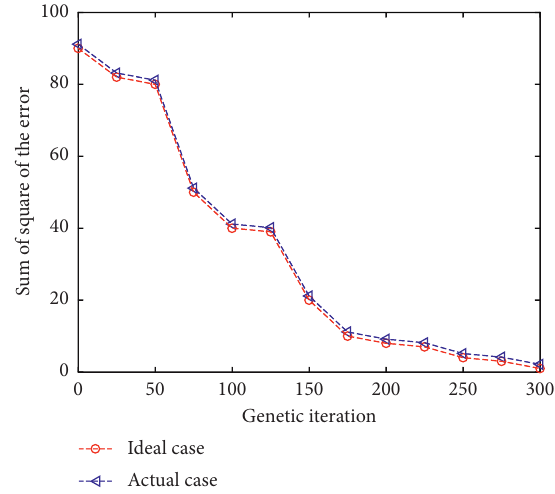
Figure 4: The curve of the sum of the square of the